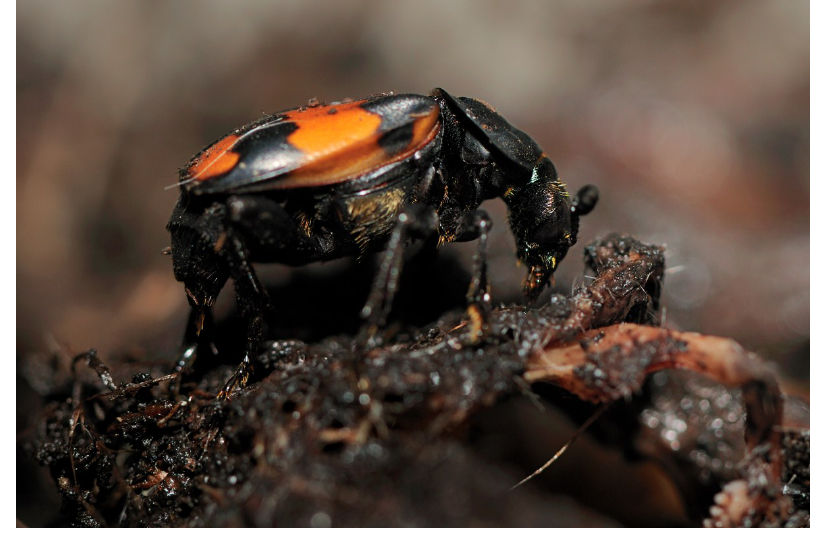
Figure 1. Nicrophorus vespilloides preparing the carcass. Photo courtesy of O.